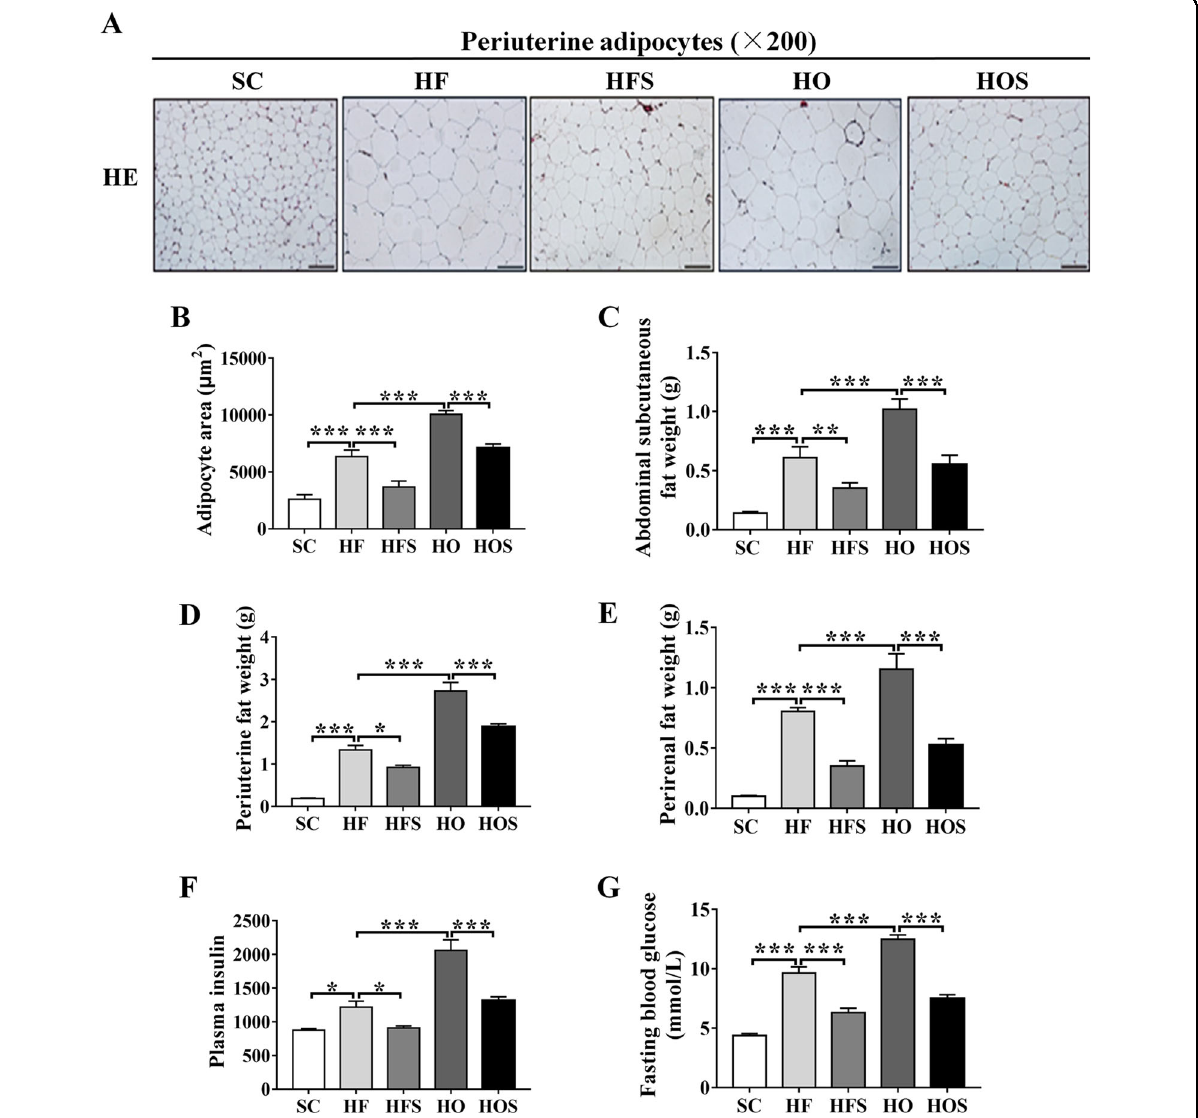
Fig. 2 Salubrinal reduced adipocyte tissue mass. a Representative H&E staining images showing salubrinal effect in periuterine tissue (200×; scale bar = 100 μ m; all graphics were in a blinded fashion). b Area of adipocytes. c Abdominal subcutaneous fat weight. d Periuterine fat weight. e Perirenal fat weight. f Serum insulin. g Fasting glucose. All values were reported as mean ± SEM ( n = 10/groups and images were taken randomly). The asterisks (*, **, and ***) represent P < 0.05, P < 0.01, and P < 0.001,